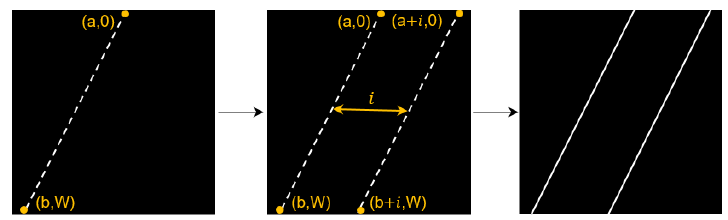
Figure 5. Procedure for generating pseudo-line